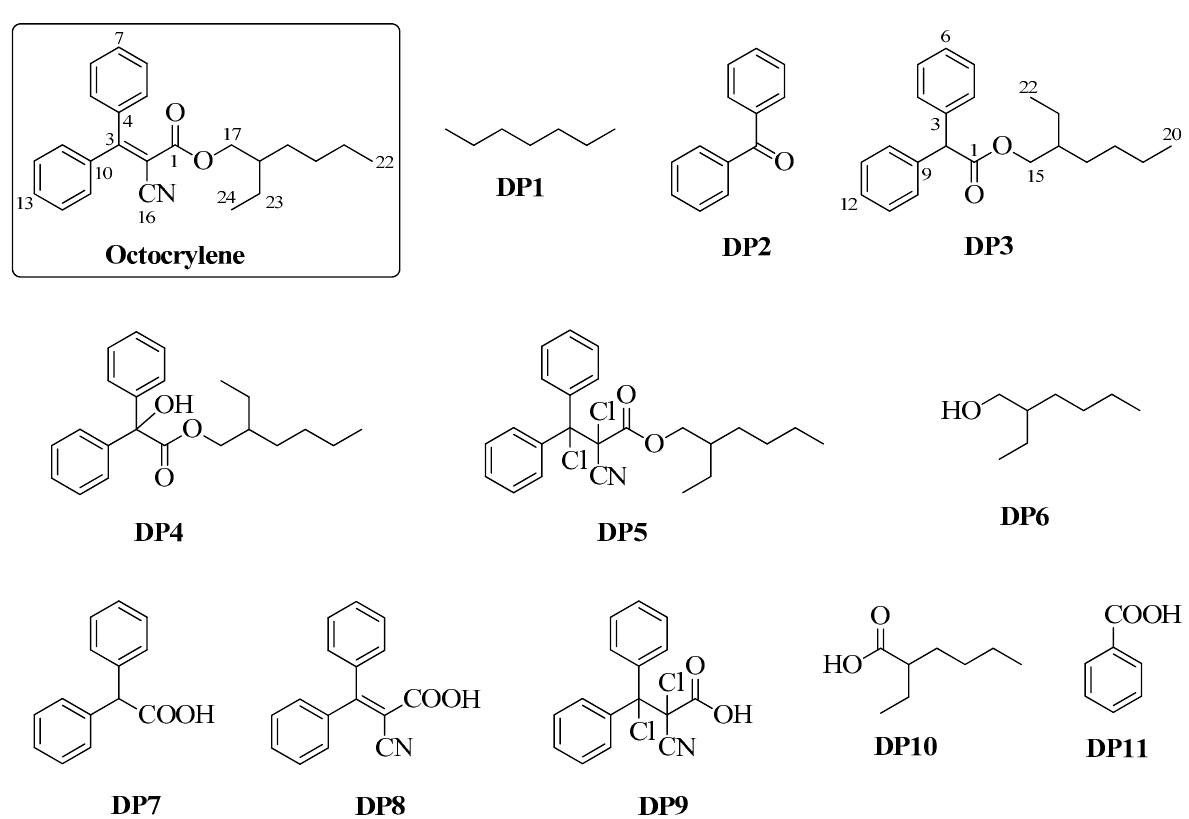
Figure 1. Chemical structures of octocrylene and its degradation byproducts DP1 – DP11 .